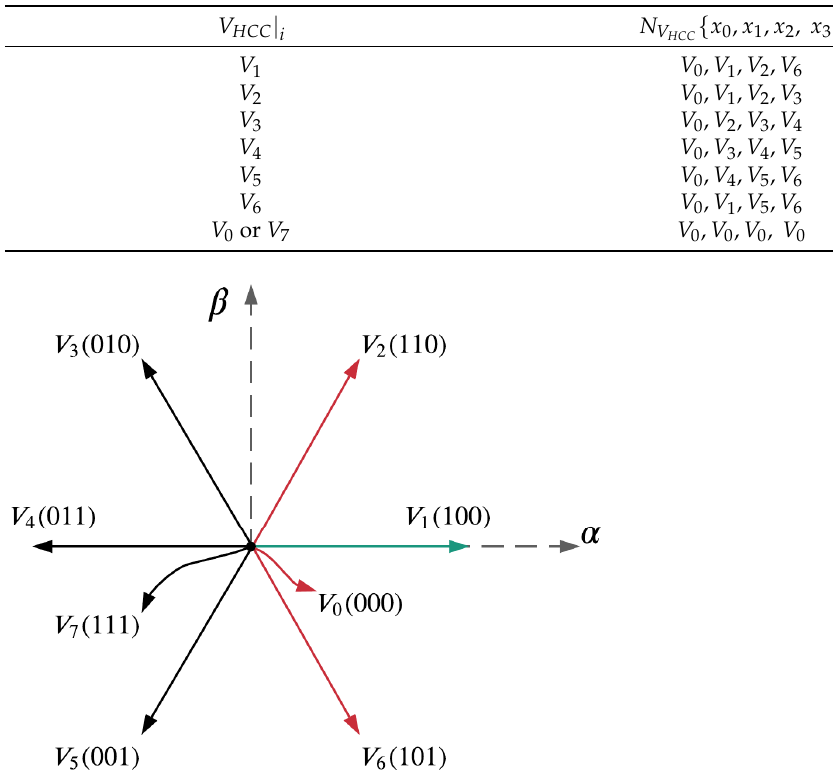
Figure 1. Hexagon VVs in the 𝞪 – 𝞫 frame and the corresponding switching states. HCC computed reference VV (green) and selected near neighbor VVs (red).